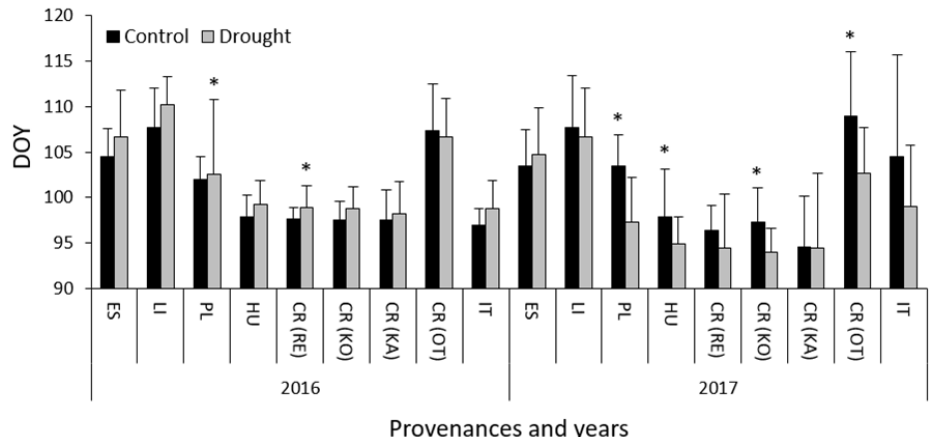
Figure 2. Provenance mean bud burst dates in the treatments (control and drought), expressed as day of year (DOY) in 2016 and 2017. Vertical bars indicate the standard deviation of the mean values. Asterisks above bars indicate significant differences between treatments for the same provenance.